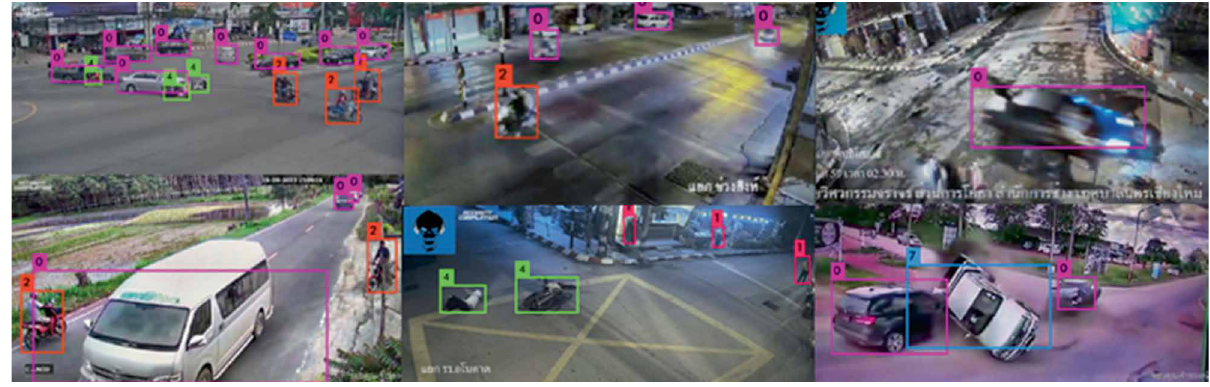
Figure 7: Yolo v3 results.